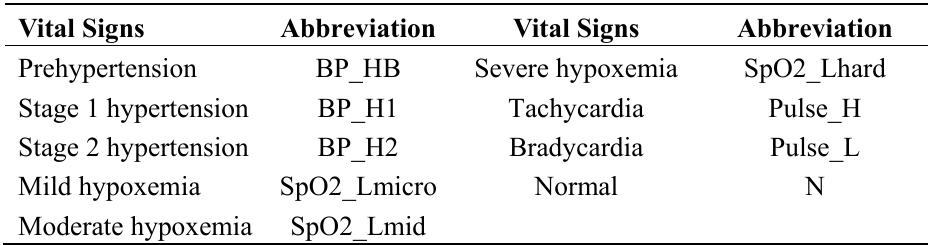
Table 2. The abbreviations of vital signs states.